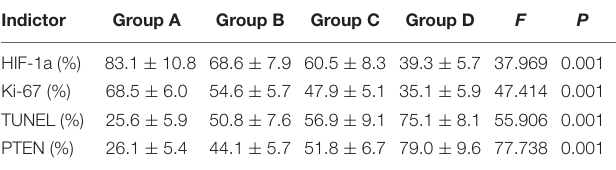
TABLE 3 | The pathological indictors at the last time point from the four groups. Indictor